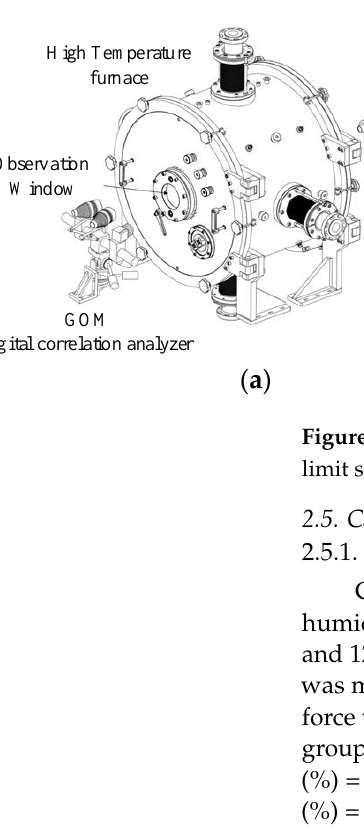
~3200 Figure 10. In situ testing device of the high-temperature in-plane biaxial apparatus. The furnace structure incorporates a digital speckle detector, a high-temperature col- orimeter, and other in situ testing devices (Figure 11). A medium-frequency induction